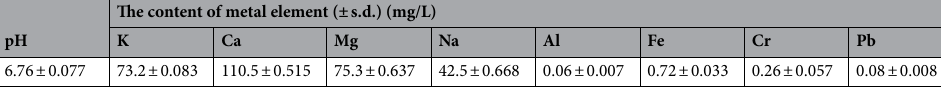
Table 1. Main components of mine water in the Fushun mining area.